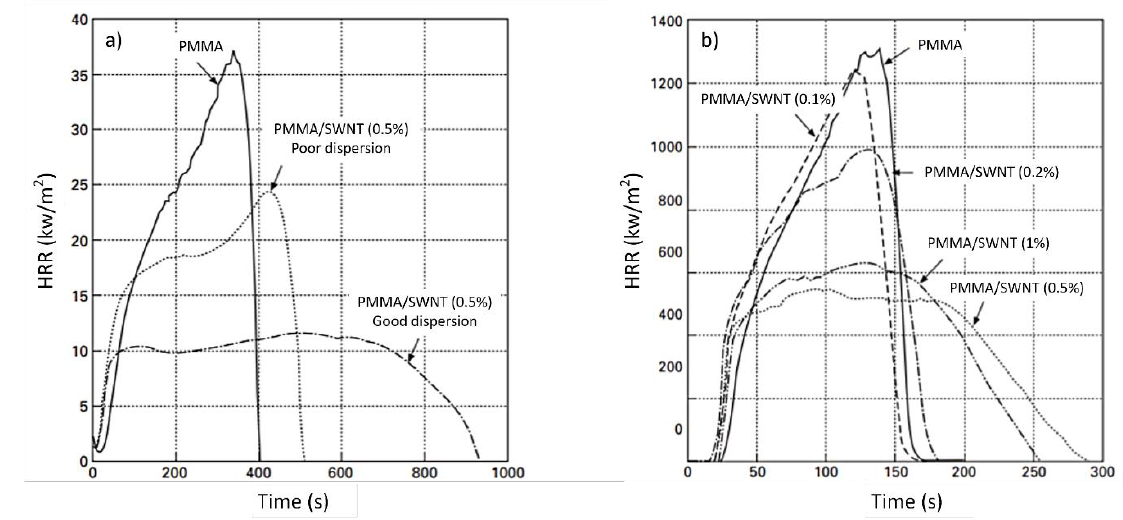
Figure 16. HRR of poly(methyl methacrylate) (PMMA) and PMMA/single-walled carbon nanotubes (SWNT) nanocompo- sites, indicating that SWNTs reduced the HRR of PMMA: ( a ) Effect of SWNT dispersion on HRR of PMMA/SWNT (0.5 wt%) nanocomposite at external radiant flux of 50 kW m − 2 . ( b ) Effects of SWNT concentration on HRR curve of PMMW/SWNT nanocomposite at 50 kW m − 2 . Reprinted with permission from Ref. [161]. Copyright 2010, Elsevier.